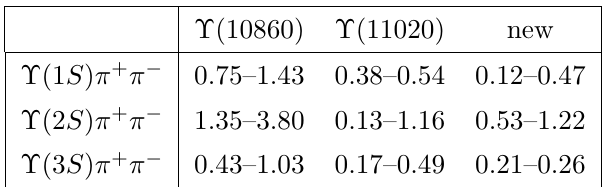
Table 4 . The ranges of the (cid:0) ee (cid:2) B values from the multiple solutions (in